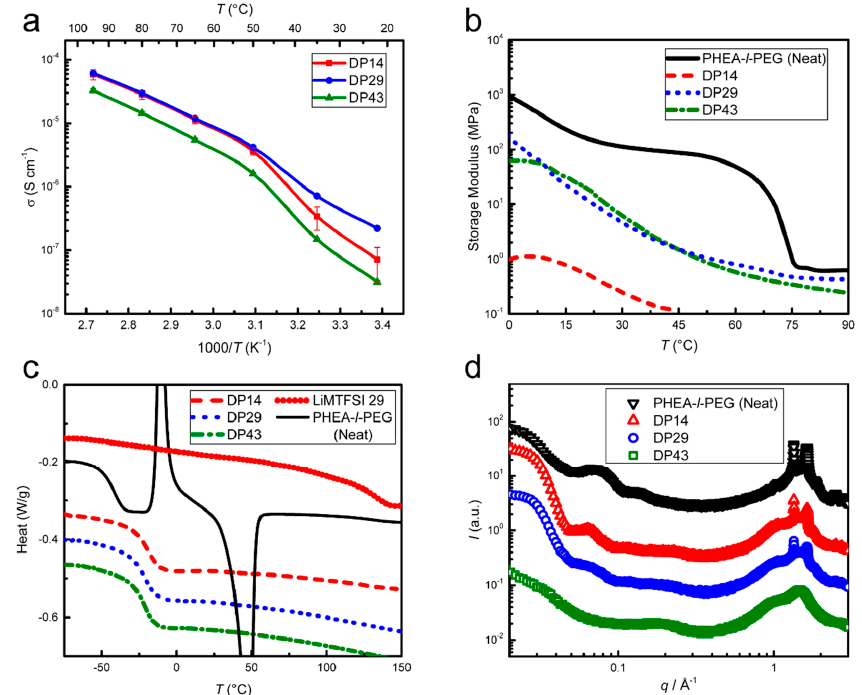
Figure 5. Characterization of SPE-3. Three different degrees of polymerization of the single-ion conductor (SIC) PLiMTFSI (DP14, DP29, DP43) for a constant Li-ion concentration ( r = 0.08) are shown.